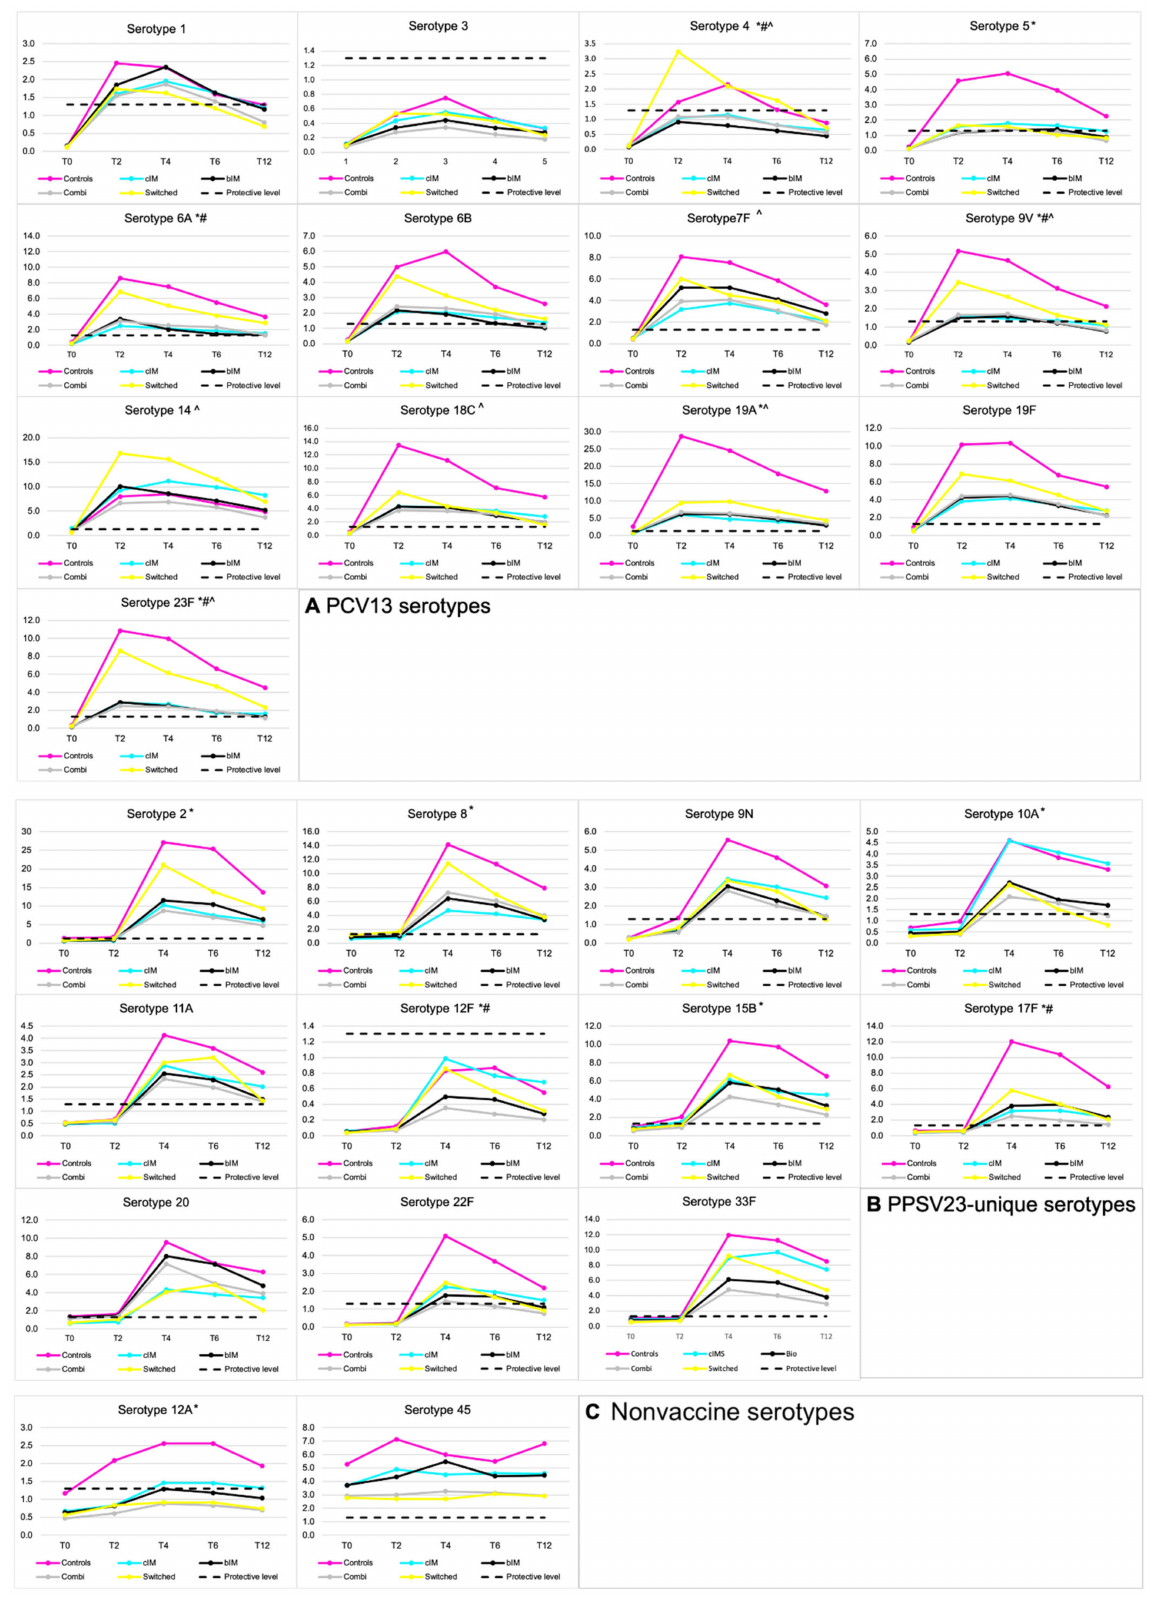
Figure 4. Serotype-specific GMCs over time for serotypes present in PCV13 ( A ), PPSV23 only ( B ), and two nonvaccine control serotypes ( C ). * Indicates statistically significant effect ( p < 0.05)